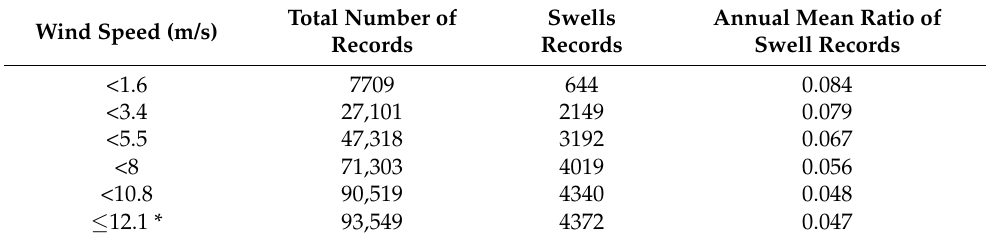
Table 1. Records of swells from Southern Hemisphere for different wind velocity threshold values.